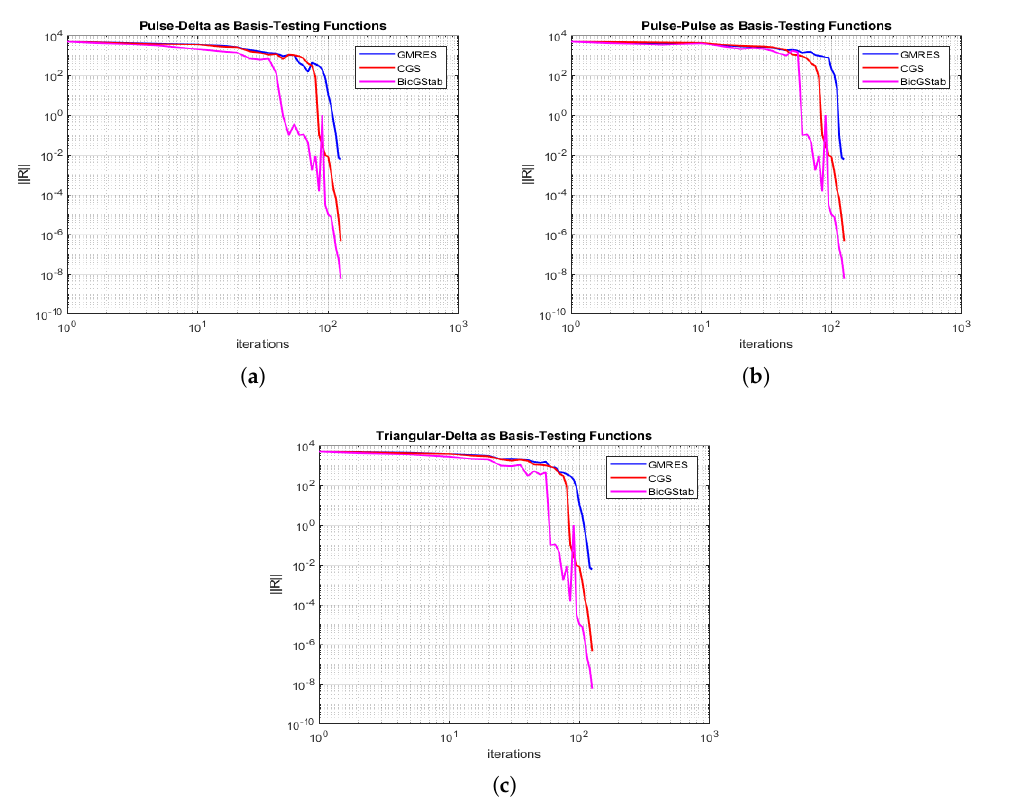
Figure 10. (cid:107) R (cid:107) vs. number of iterations for GMRES. CGS and BicGStab algorithms: ( a ) pulse–delta ( b ) pulse–pulse ( c ) triangular–delta functions as basis-testing functions.